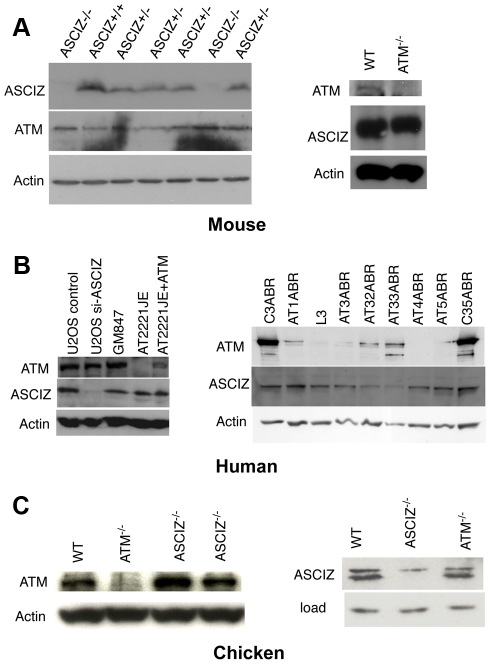
Reciprocal independence of ASCIZ and ATM protein levels.(A) Protein levels in mouse tissues. Left panel, Western blot analysis of head extracts of a randomly chosen litter from an Asciz heterozygote intercross at E12.5. Right panel, brain extracts of WT and Atm-null littermate mice [20]. (B) Protein levels in human cell lines. Left panel, adherent cells: U2OS osteosarcoma cells treated with GL2 control or Asciz siRNA; GM847 control fibroblasts, Atm-deficient AT2221JE fibroblasts containing an empty-vector control (FTY pEBS7) or reconstituted with WT Atm (FTYZ5) [23]. Right panel, lymphoblastoid cell lines from healthy donors (C3ABR, C35ABR) and seven separate AT patients (L3 and AT1ABR–AT33ABR); note that ATM was immunoprecipitated before blotting as described [24]. (C) Protein levels in chicken DT40 B cell lysates. Left panel, comparison of ATM levels in two independent Asciz-deleted clones using the anti-chicken ATM antibody and the ATM-deleted DT40 clone as specificity control. Right panel, comparison of ASCIZ levels in WT and an Atm-deleted clone [25] with an Asciz-deficient clone [16] as antibody specificity control (NB, anti-human ASCIZ was used at 1∶100 dilution rather than 1∶2000–1∶4000 for mouse or human samples).